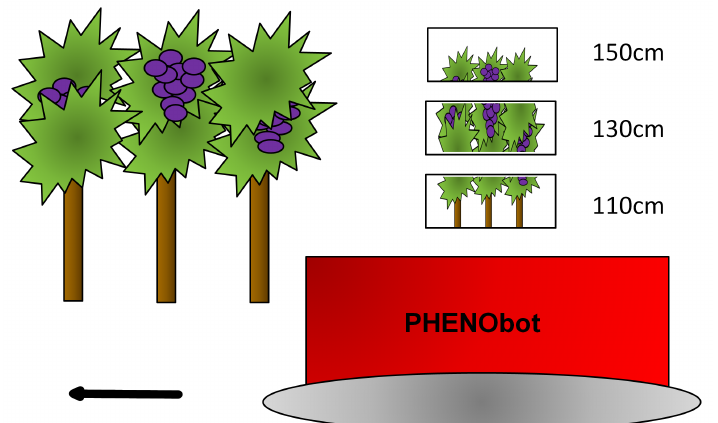
Figure 5. Data acquisition using the PHENObot. Please note that the three camera frames shown simultaneously only serve as an illustration for the height coverage achieved using three separate camera